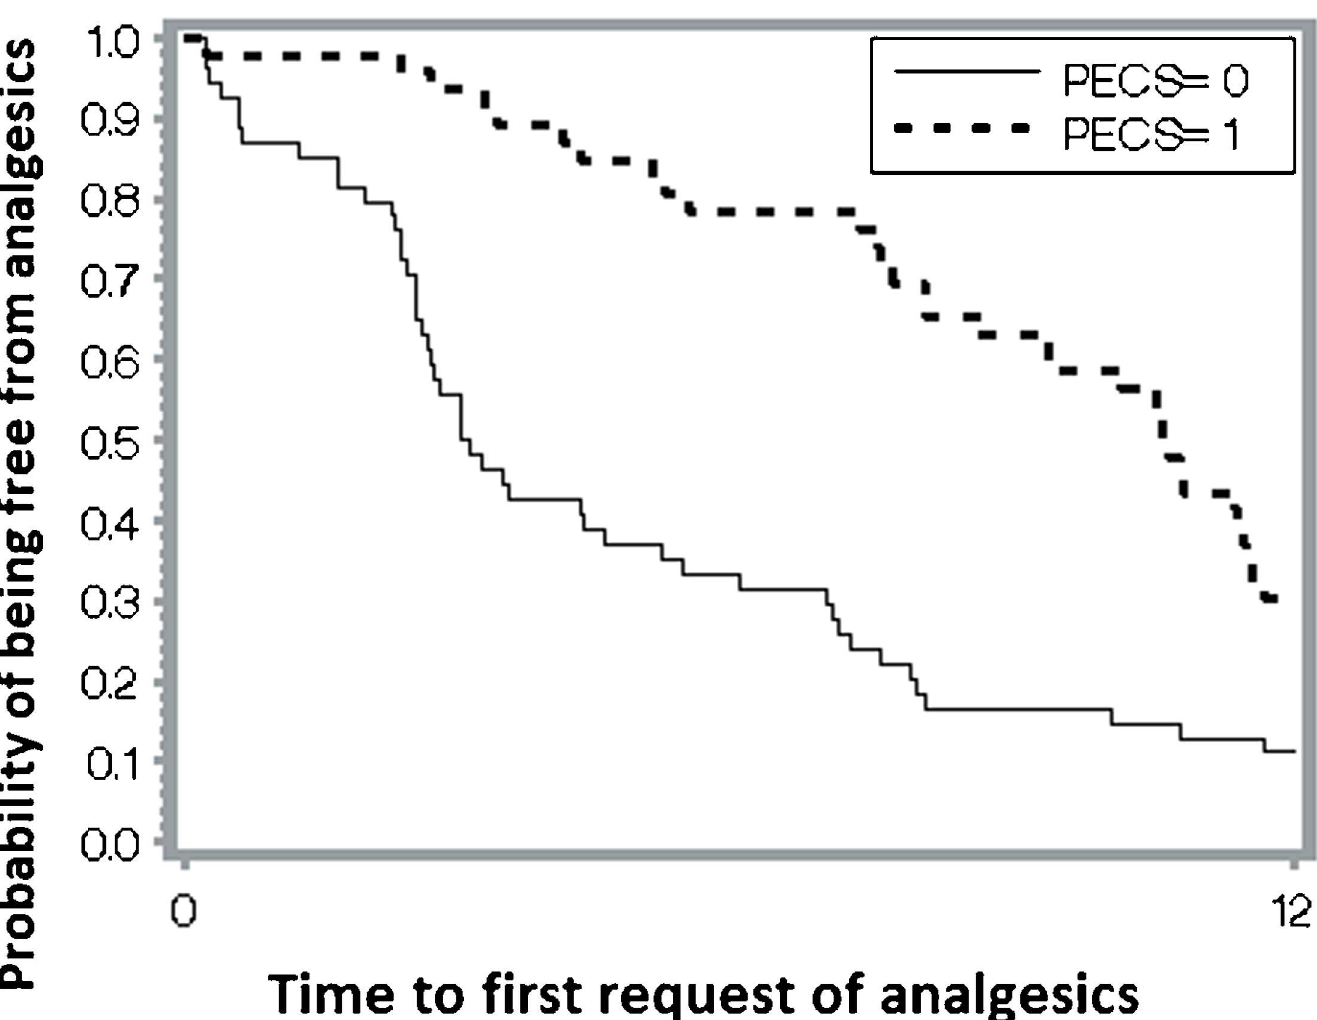
Fig 4. Time to the first request of analgesics. Kaplan Meier analysis illustrating the difference between the two groups in the proportion of patients with tolerablelevel of pain until the first request of analgesics. p = < 0.0001,